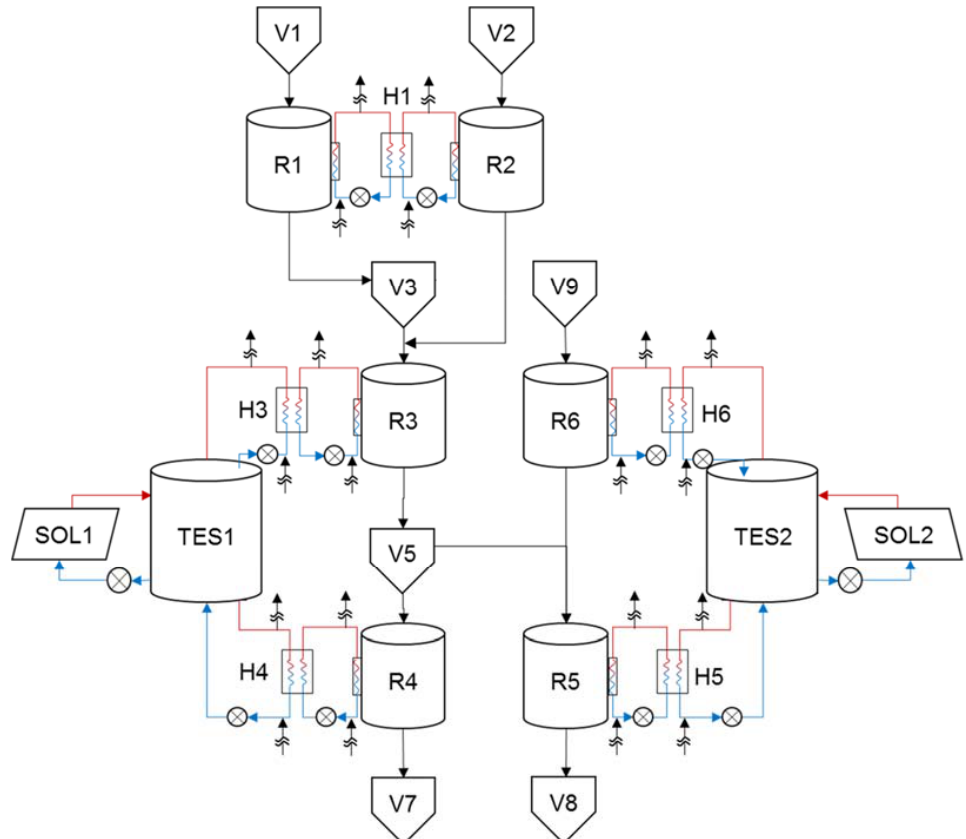
Figure 15. Plant topology.